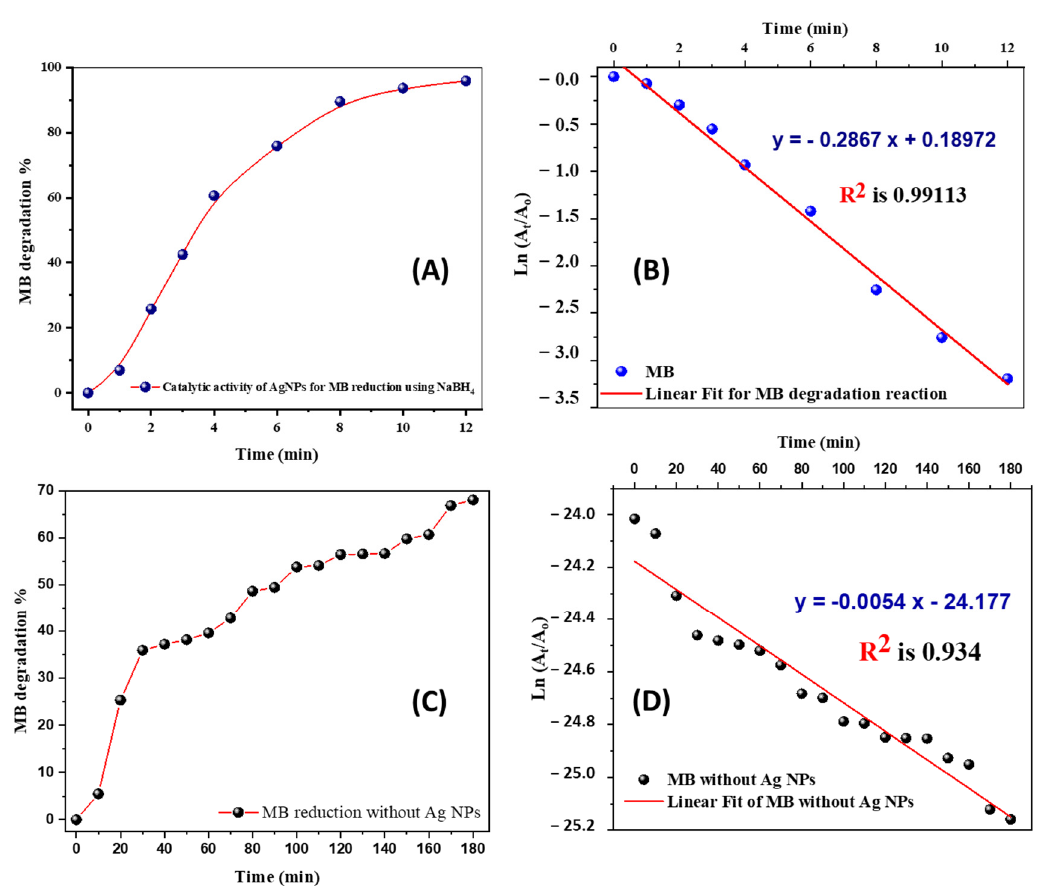
Figure 10. The catalytic reduction percentage (%) of MB versus the reaction time in the ( A ) existence and ( C ) absence of the GC-capped Ag NPs catalyst; ( B , D ) are pseudo-first order kinetics; the linear relationship between ln and time (min) is shown above.